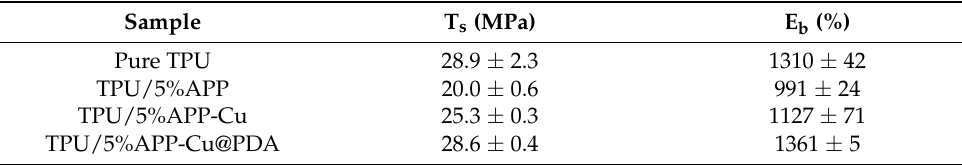
Table 4. Tensile tests for pure TPU and TPU composites.